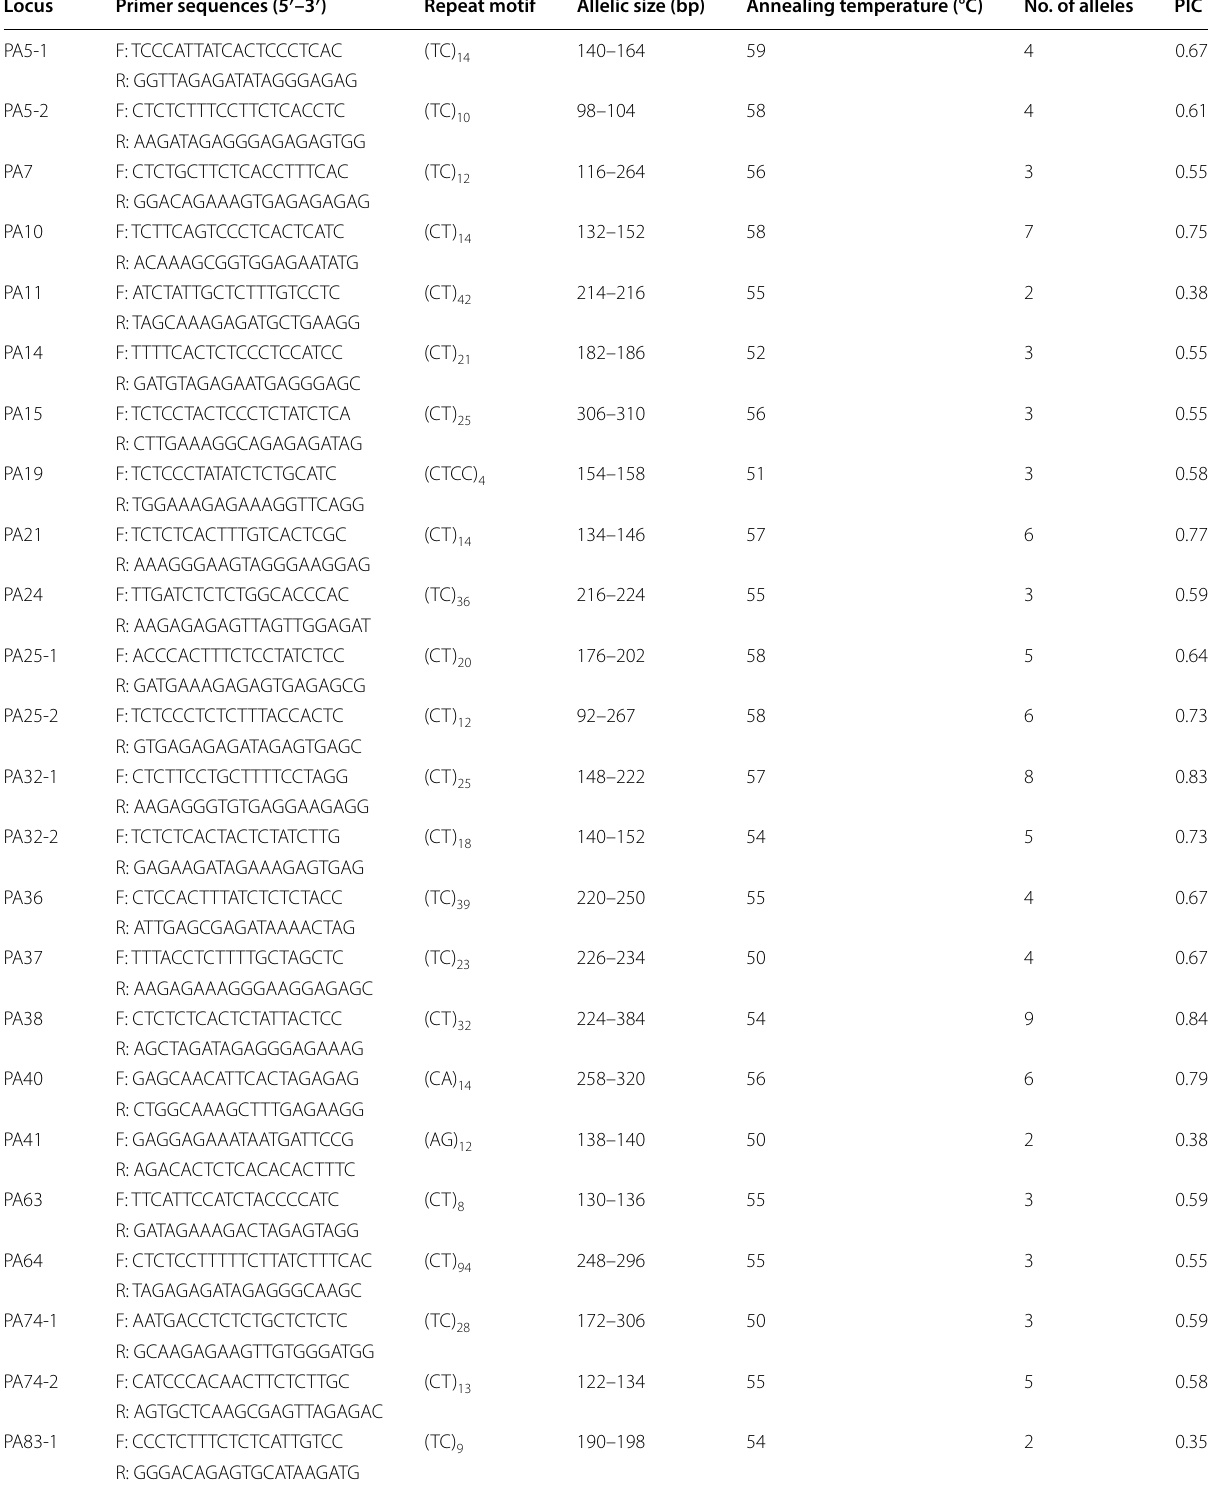
Table 2 Characteristics of the 28 polymorphic microsatellite primers derived from Phalaenopsis aphrodite subsp. for-